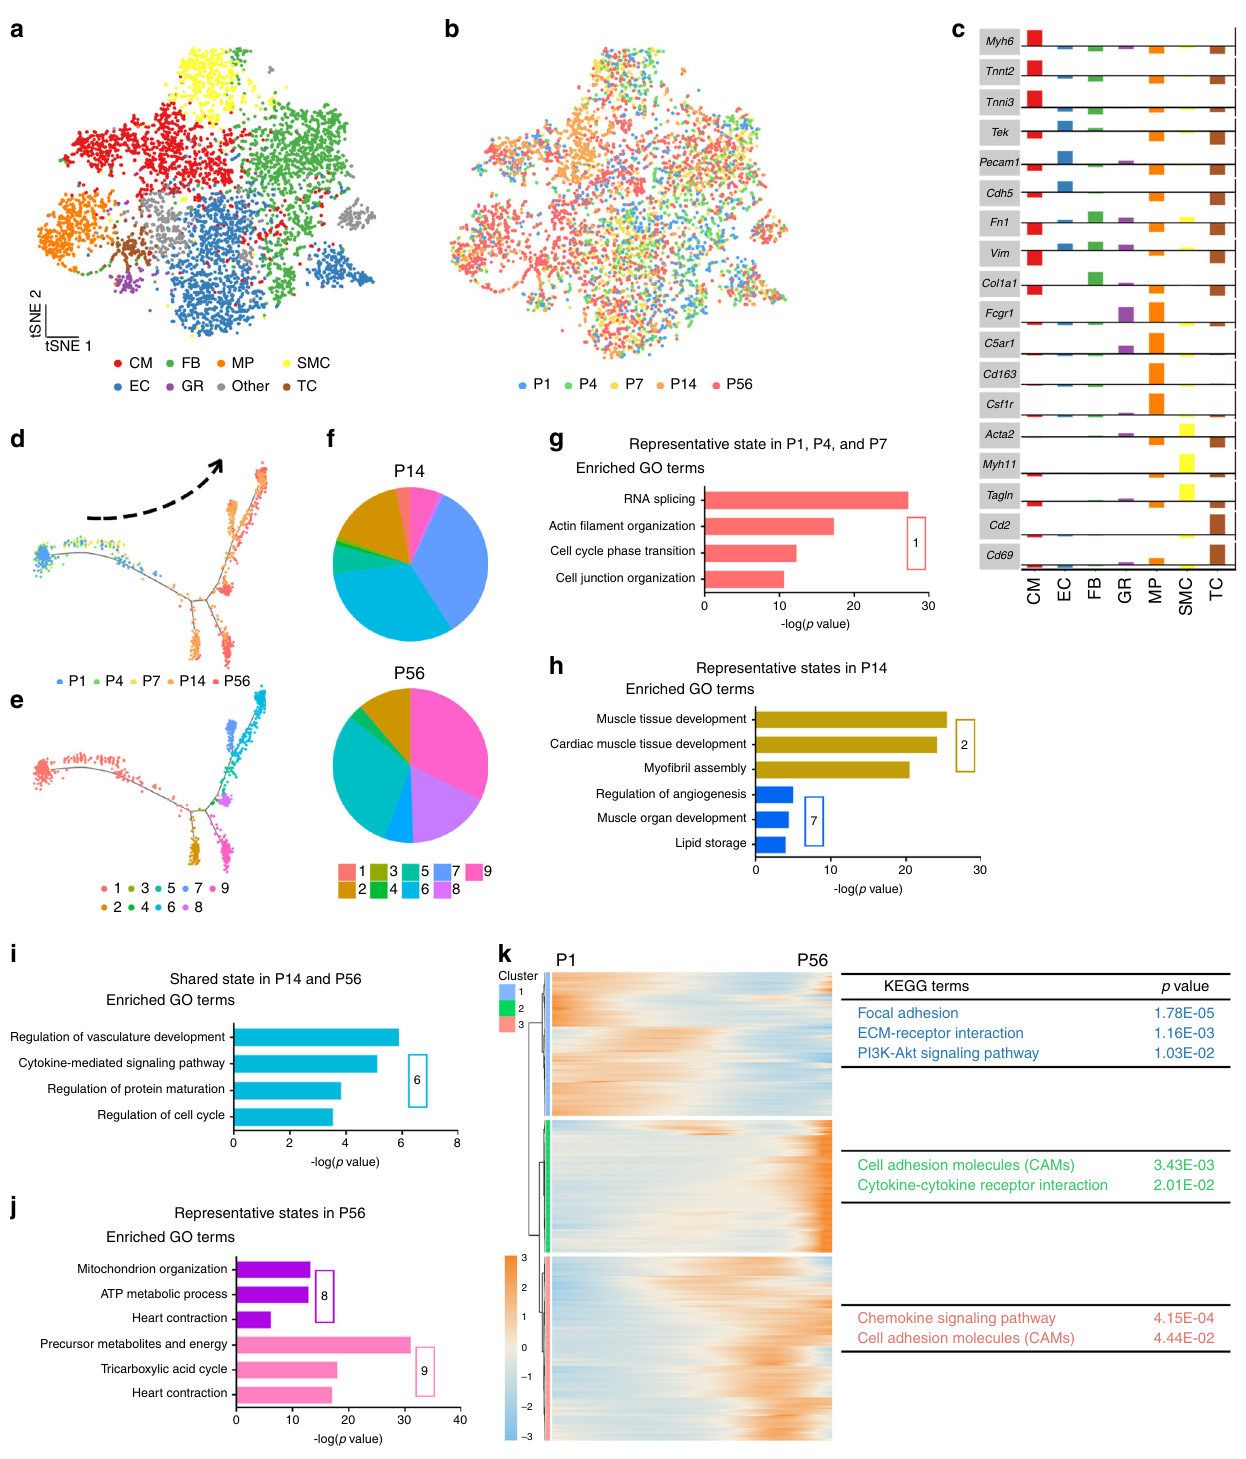
Fig. 1 Single-cell analysis of murine postnatal heart development. a , b t -distributed stochastic neighbor embedding ( t -SNE) clustering of single cells from postnatal day 1 (P1), P4, P7, P14, and P56 hearts. CCA was applied to remove batch effects. Cells were colored by cell type ( a ) or time point ( b ). CM cardiomyocyte, EC endothelial cell, FB fi broblast, MP macrophage, SMC smooth muscle cell, TC T cell, GR granulocyte. c Cell populations in a were identi fi ed by the expression of established marker genes. d , e Monocle analyses showing the ordering of CMs in pseudotime. Each color indicates either a time point ( d ) or a cell state ( e ). f State proportions of CMs from P14 or P56 hearts, respectively. g – j Gene ontology (GO) analysis of genes speci fi cally expressed in a given CM state from e . Selected top categories are shown here (Supplementary Data 1 – 6). k Heatmap to display different blocks of top 1000 differentially expressed genes (DEGs) along the pseudotime trajectory ( d , e ). Please see Supplementary Data 7 for the full list. Right: selected top Kyoto Encyclopedia of Genes and Genomes (KEGG) terms related to corresponding DEGs in blocks signi fi cantly changed during cardiomyocyte maturation (P1 – P56), Functional analysis was performed with enrichKEGG in clusterPro fi ler, p < 0.05 was considered signi fi cant